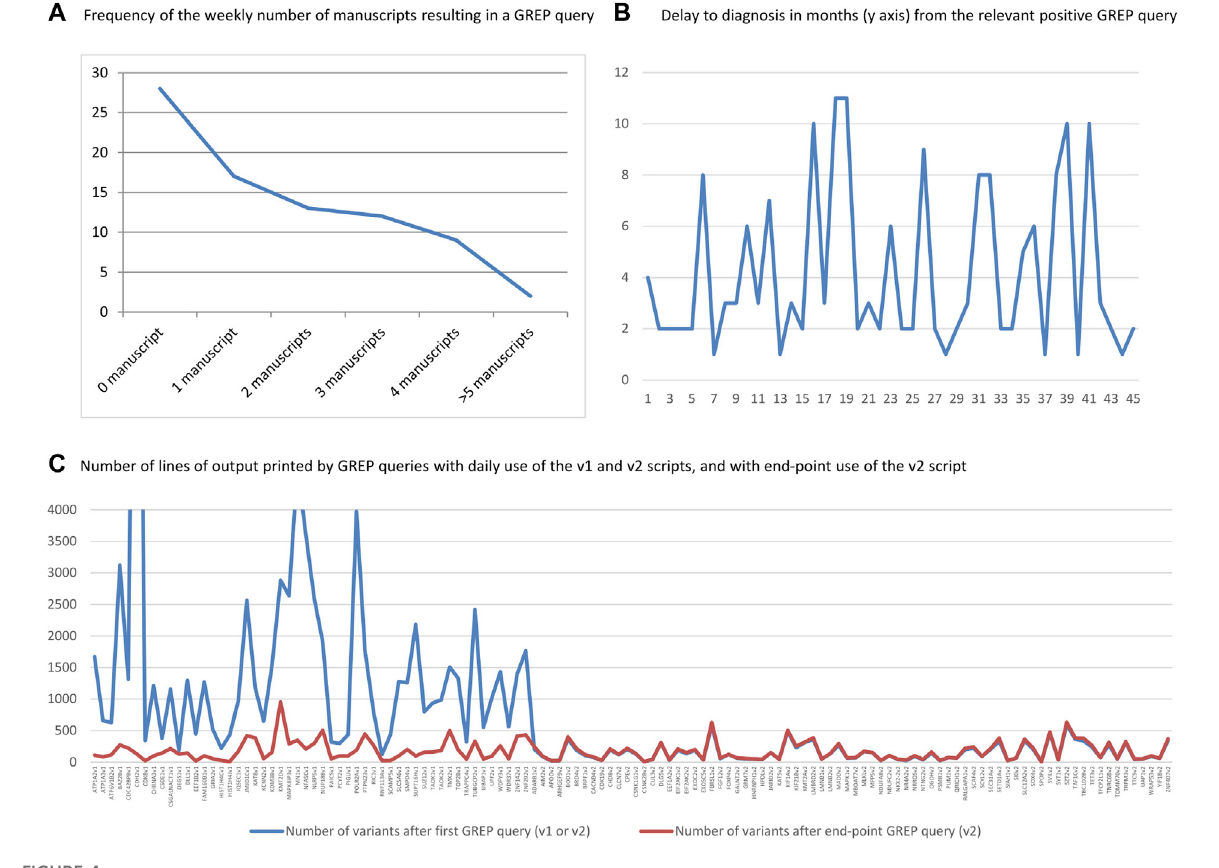
FIGURE 4 (A) Number of weeks with the speci fi ed number of manuscripts resulting in a GREP query. (B) Delay in months between positive GREP query and diagnostic report. (C) Number of lines of output printed by GREP queries for each of the 128 genes, for daily queries using the v1 and v2 scripts and end- point GREP queries using the v2 script. Note the drastic difference between v1 and